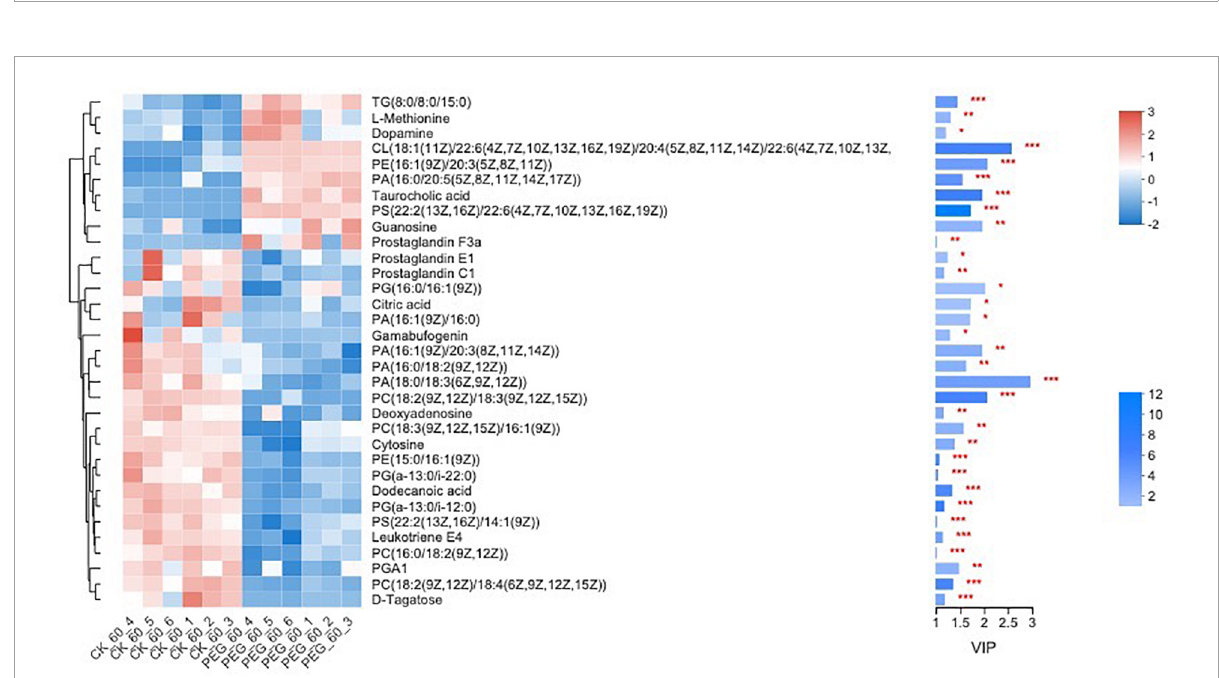
FIGURE6 Heatmap of the differentially accumulated metabolites in sainfoin silage (CK 60, control group after 60 days of ensiling; PEG 60, PEG treated group after 60 days of ensiling). ∗ p < 0.05, ∗∗ 0.01 < p < 0.05, ∗∗∗ p < 0.01.